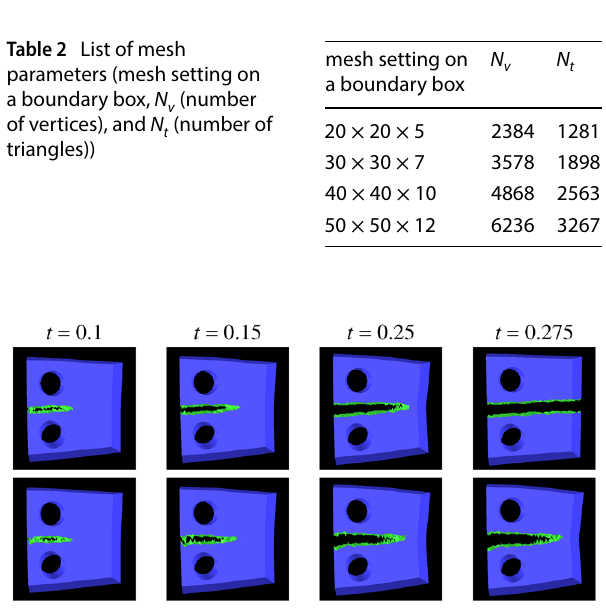
Fig. 8 Initial crack growth in a 3D isotropic media with given boundary displacement ⃗ g = ( 0,2,0 ) × t , ϵ = 0.05